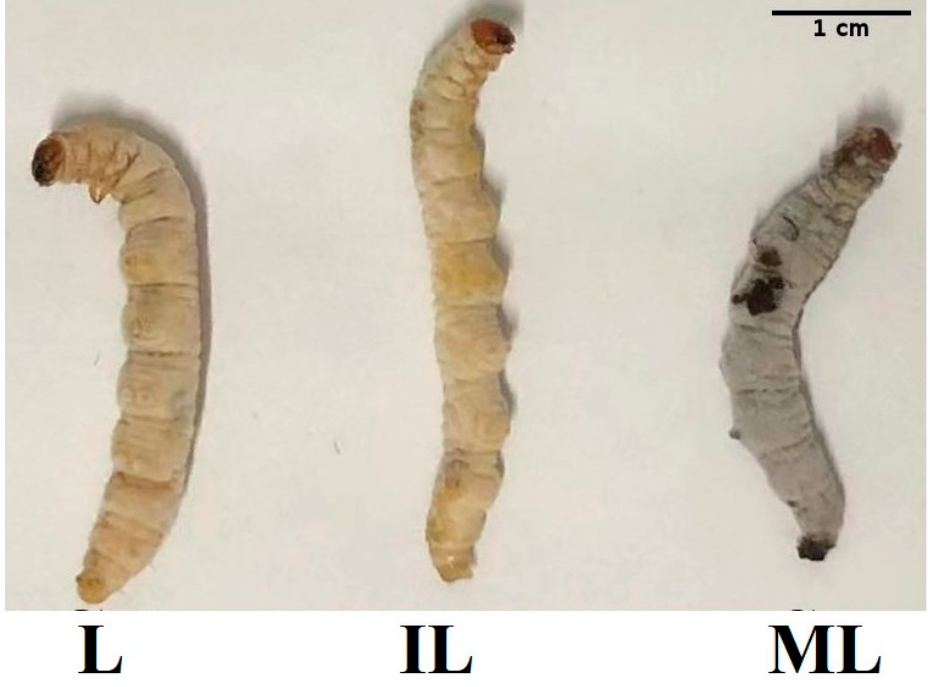
Figure 1. O. sinensis samples collection for transcriptome sequencing. IL represents one-year post- infected larva of H. xiaojinensis by O. sinensis . L represents the pre-infected larva of H. xiaojinensis . ML represents the mummified larva of H. xiaojinensis. Scale = 1 cm.